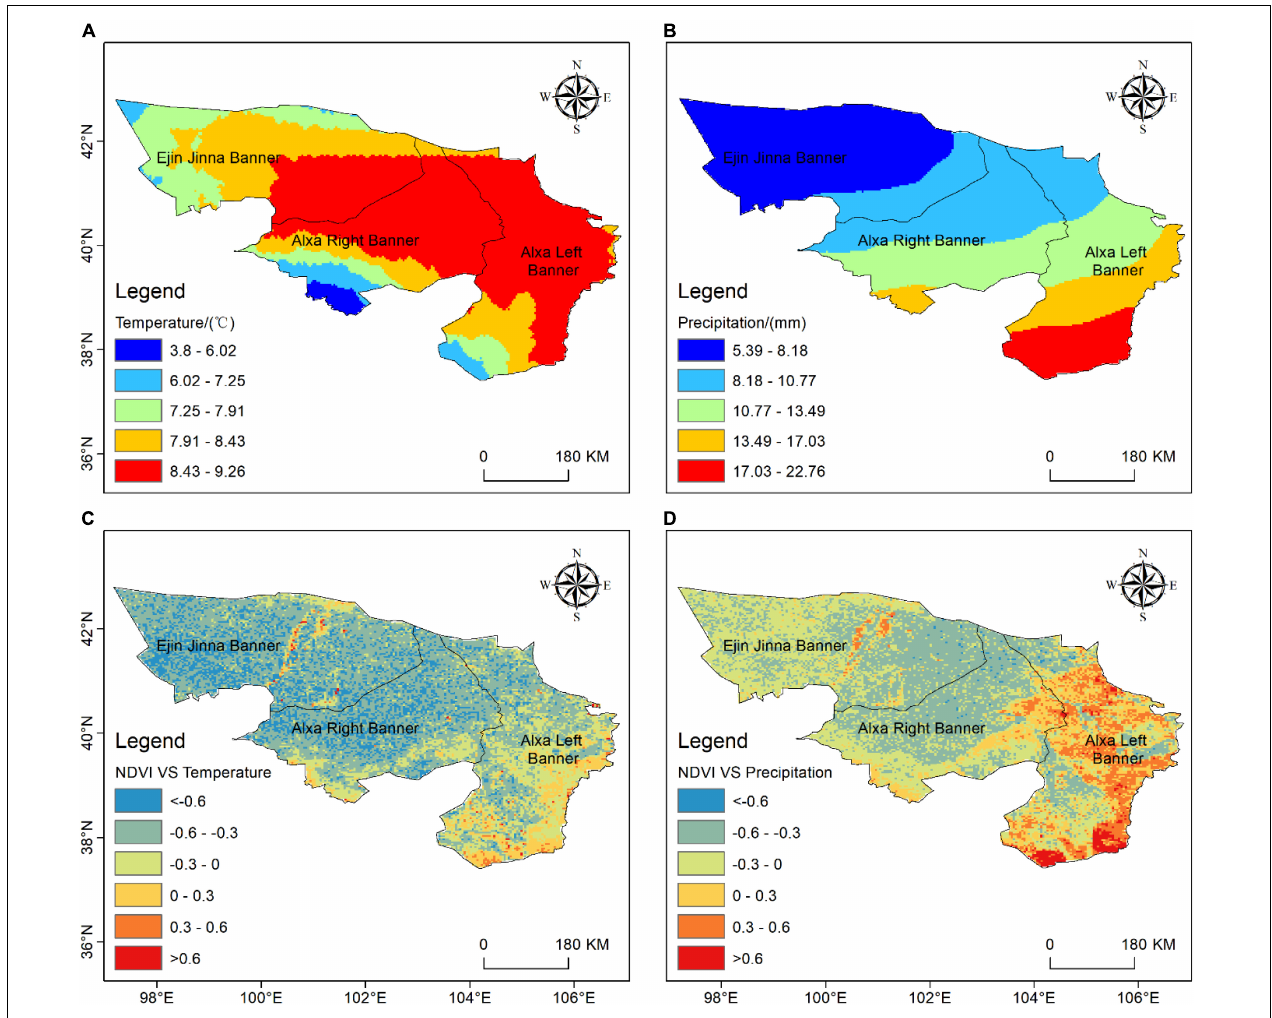
FIGURE 7 | Spatial distribution of mean air temperature and precipitation in Alxa League from 2000 to 2019 and their correlation with